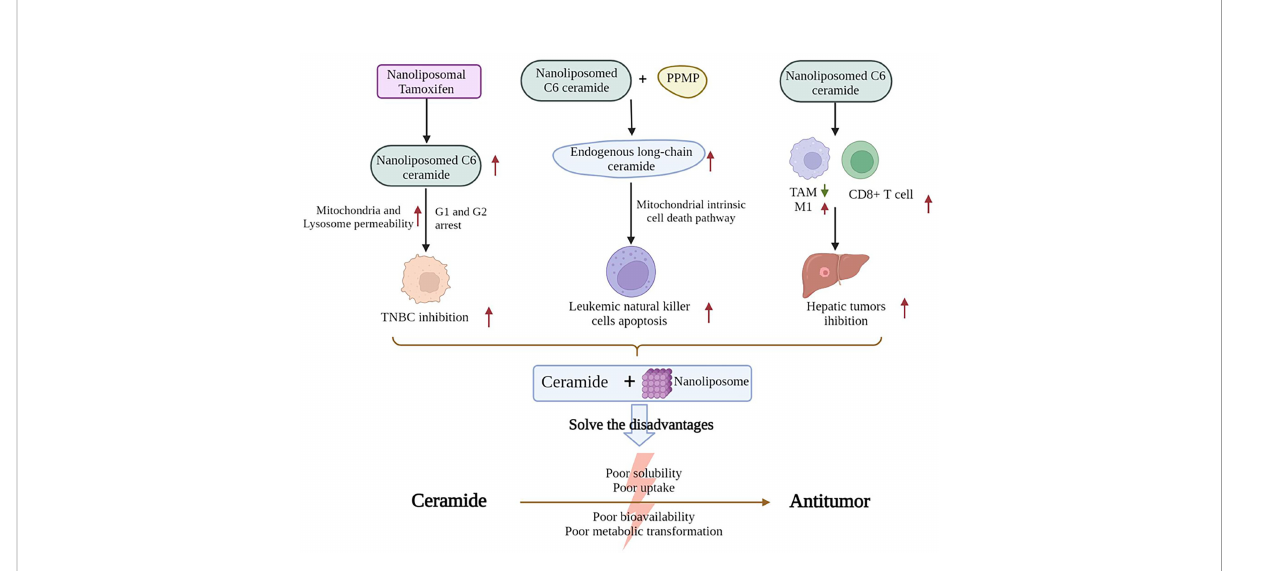
FIGURE 2 Nanoliposomes improve the antitumor activity of